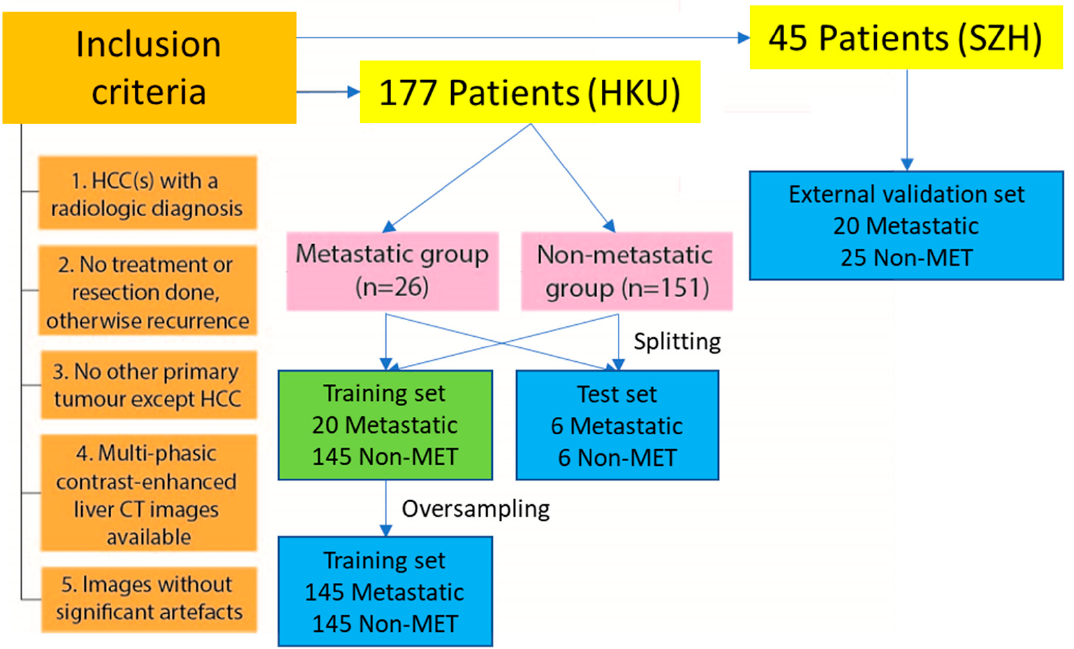
Figure 1. Flowchart of research case inclusion; Significant artefacts include breathing, moving, shunts or the iodized oils artefacts.